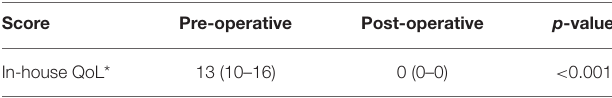
TABLE 3 | Pre- and post-operative in-house QoL